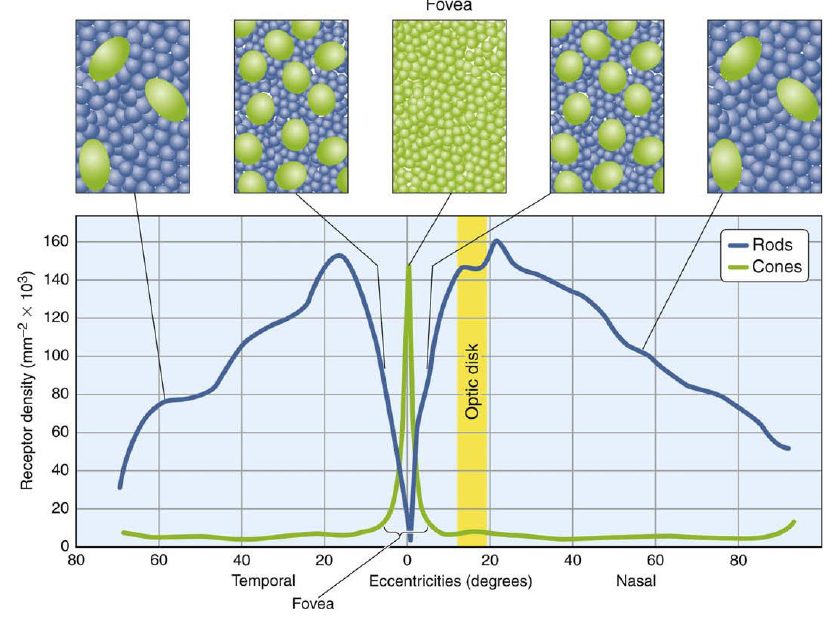
Figure 1. Distribution of photoreceptors in retina of the eye [9].